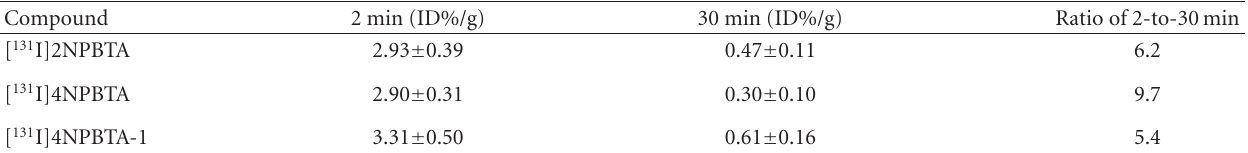
Table 1: Brain uptake and clearance.